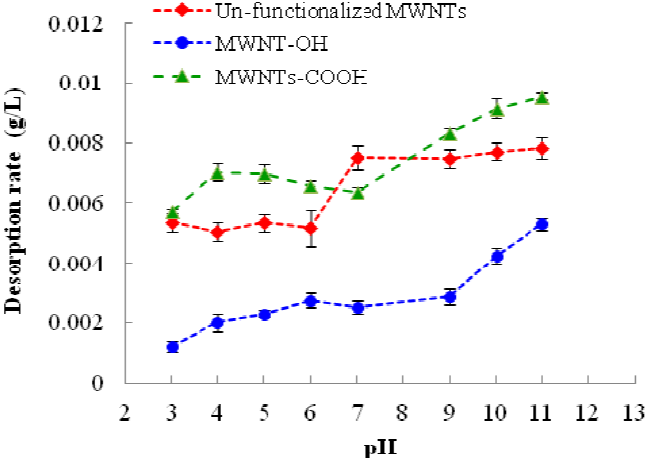
Figure 2. Change of the desorption rate of pre-loaded 1,3,5-TCB from MWNTs with solution pH. The reported values are the average of three or four replicates. Error bars represent standard